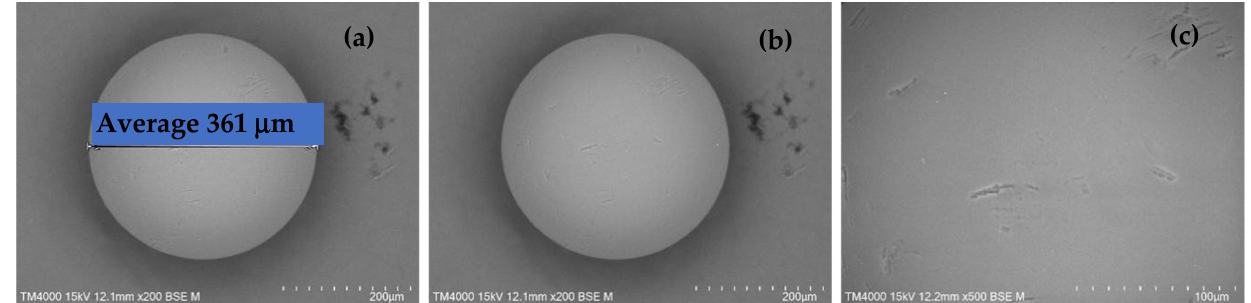
Figure 1. High-magnification SEM images of H + Dowex-M4195 chelating resin at a magnification of ×200; ( a ) average dimensions, ( b ) spherical form and ( c ) the surface of resin.